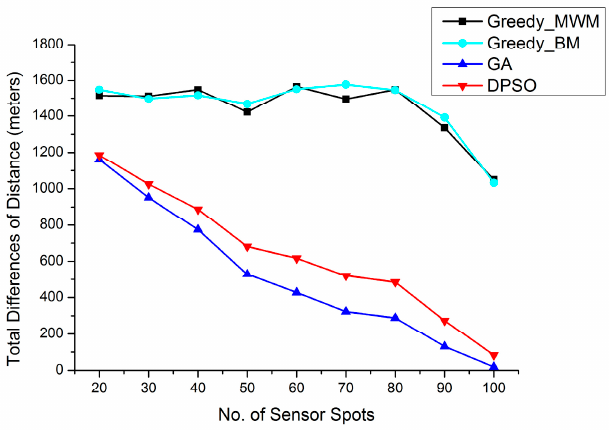
Figure 6. Differences in the total traveled distance under the greedy algorithms, GA, and DPSO algorithm.